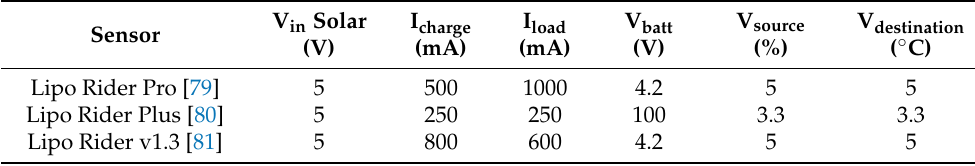
Table 6. Comparison of charge